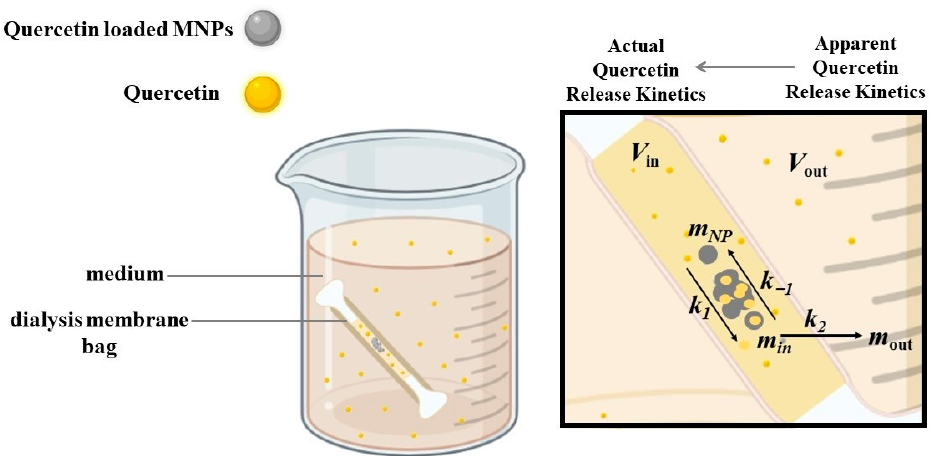
Figure 1. Experimental setup for studying the quercetin release kinetics under non-sink condi- tions.